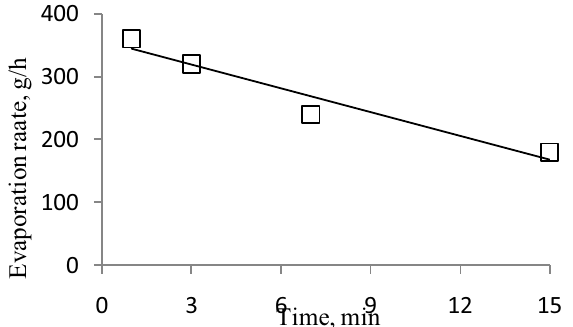
Fig. 4. Time dependence of the evaporation rate for WO 3